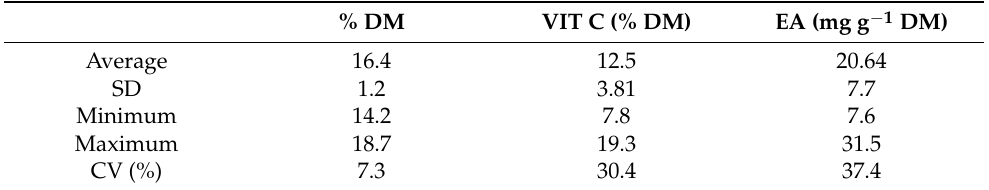
Table 1. Descriptive statistics for the measurement of vitamin C and ellagic acid in Kakadu plum fruit samples analysed using NIR spectroscopy.